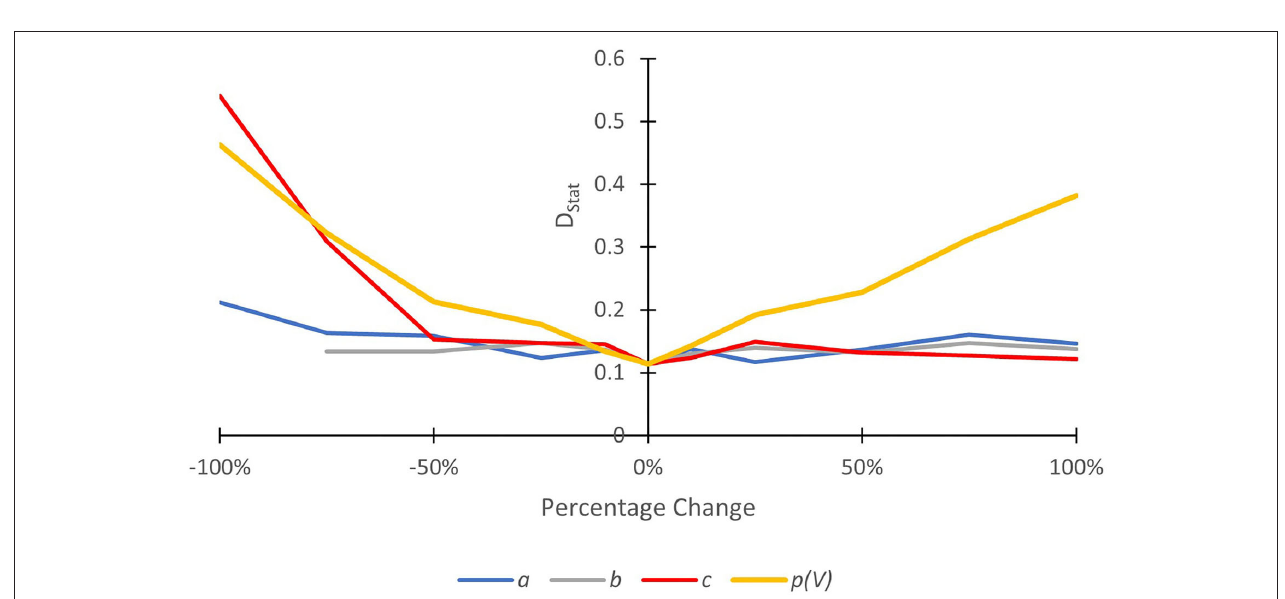
FIGURE 8 | Results from a one-at-a-time sensitivity analysis, showing the change in model goodness of fit (deviation between the predicted and observed CDFs, D Stat ) for the parameters a , b , c , and p ( V ). High change in D Stat for a given percentage increment in the parameter value away from its optimum (0%) indicates a high degree of sensitivity to that parameter.